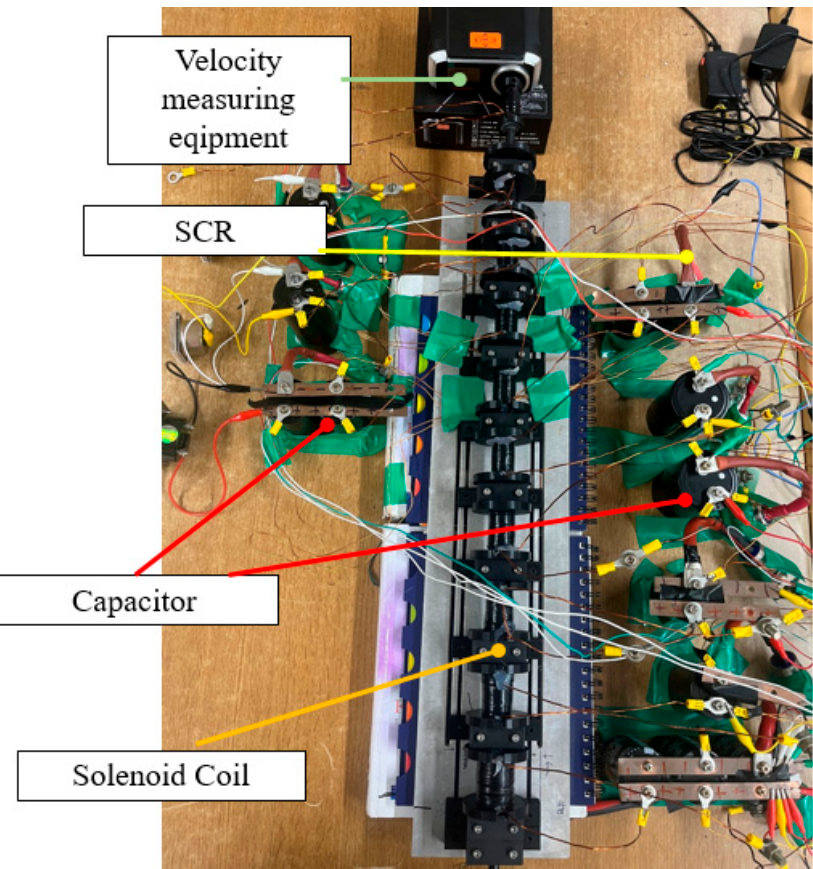
Figure 5. The nine-stage coil gun with certain solenoid coil and capacitors highlighted.